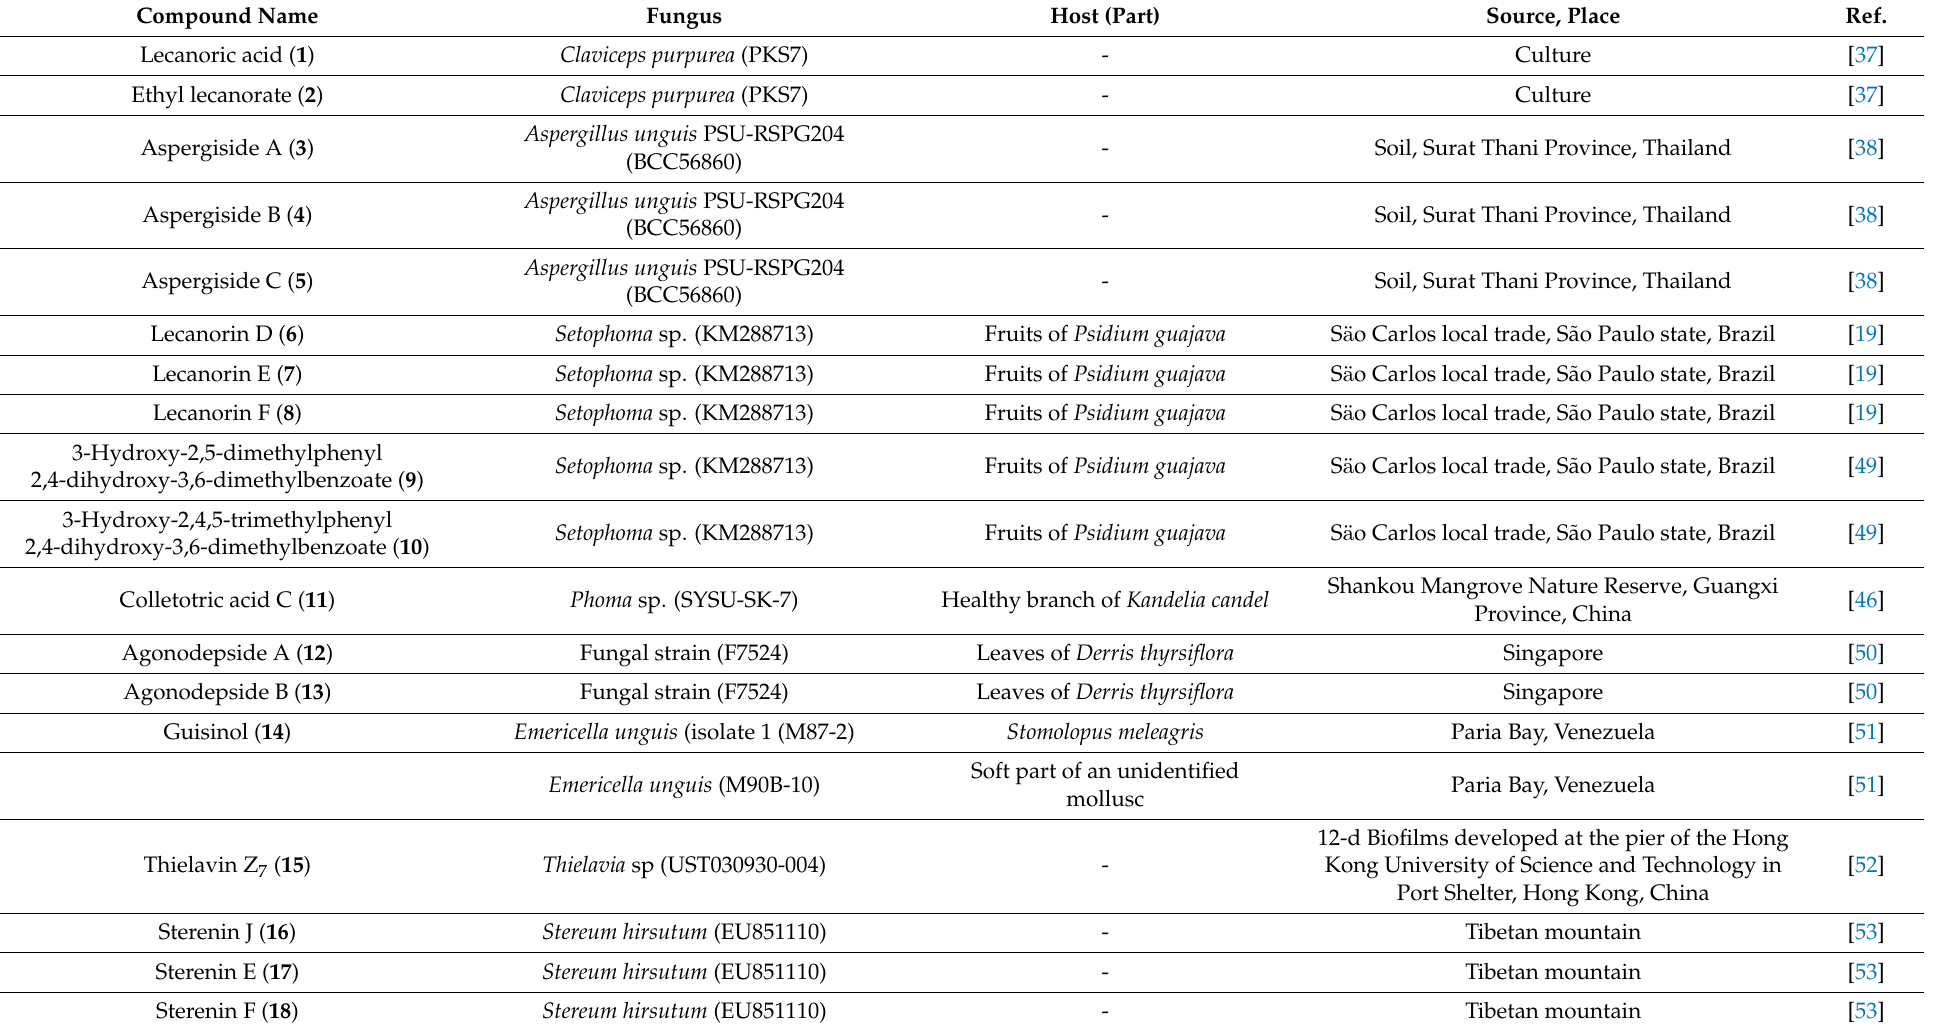
Table 1. List of fungal depsides (Fungal source, host, and